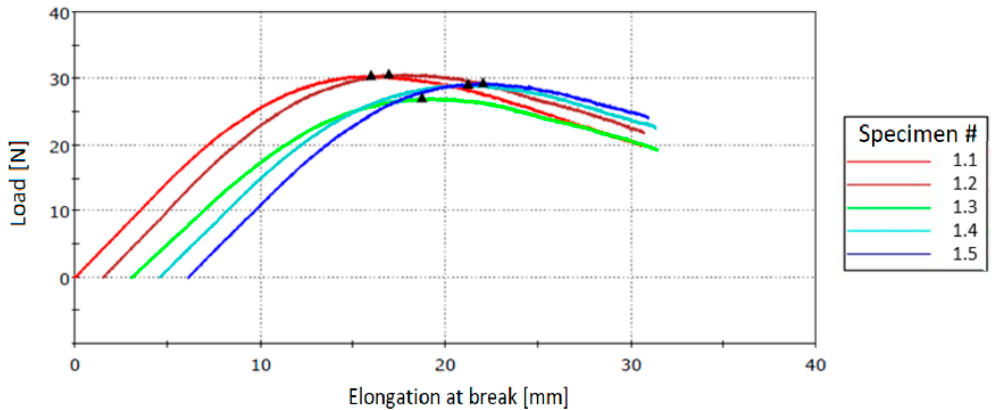
Figure 24. Stress–strain curves for specimens cured at 80 °C for 2 h.